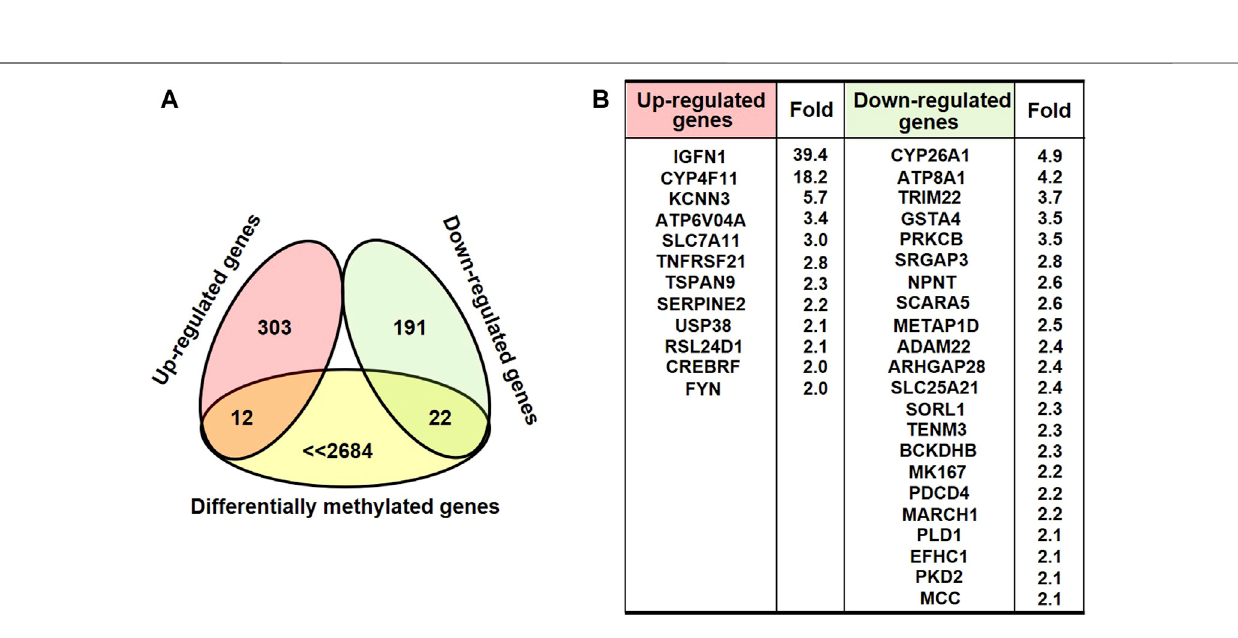
Frontiers in Bioengineering and Biotechnology |